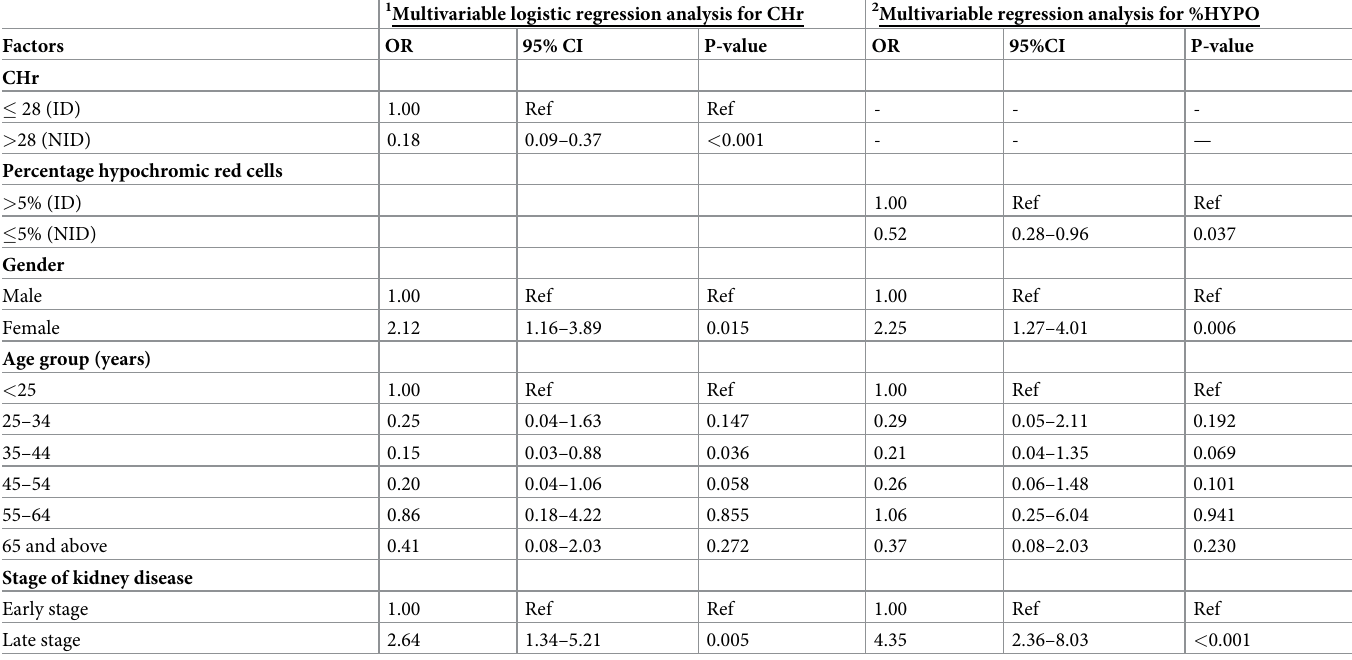
Table 5. Relationship between reticulocyte haemoglobin content, percentage hypochromic red cells and iron deficiency anaemia among chronic kidney disease participants. 1 Multivariable logistic regression analysis for CHr 2 Multivariable regression analysis for